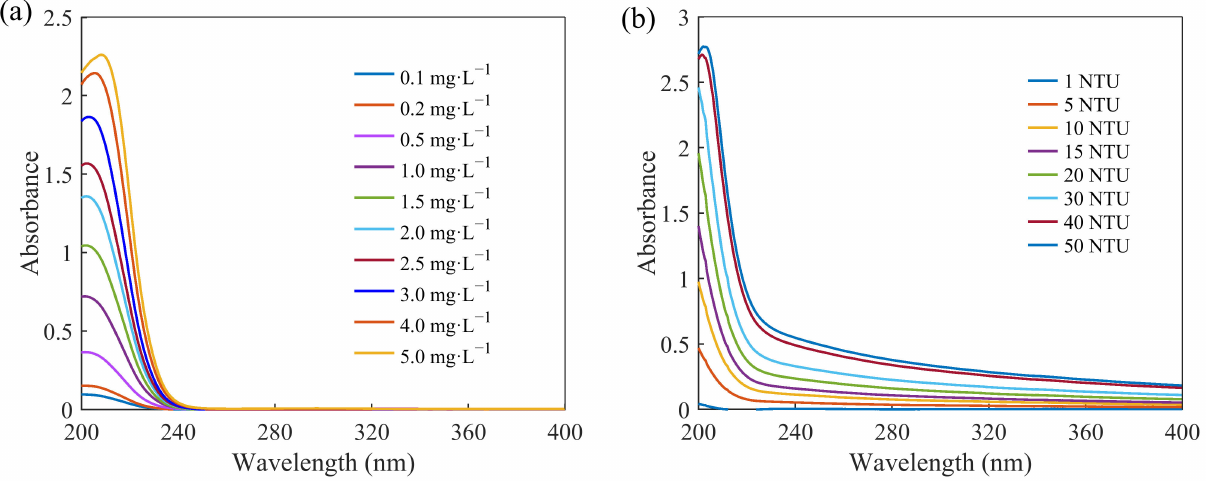
Figure 1. ( a ) Absorption spectra of solutions with different nitrate concentrations. ( b ) Absorption spectra of standard solutions with different levels of